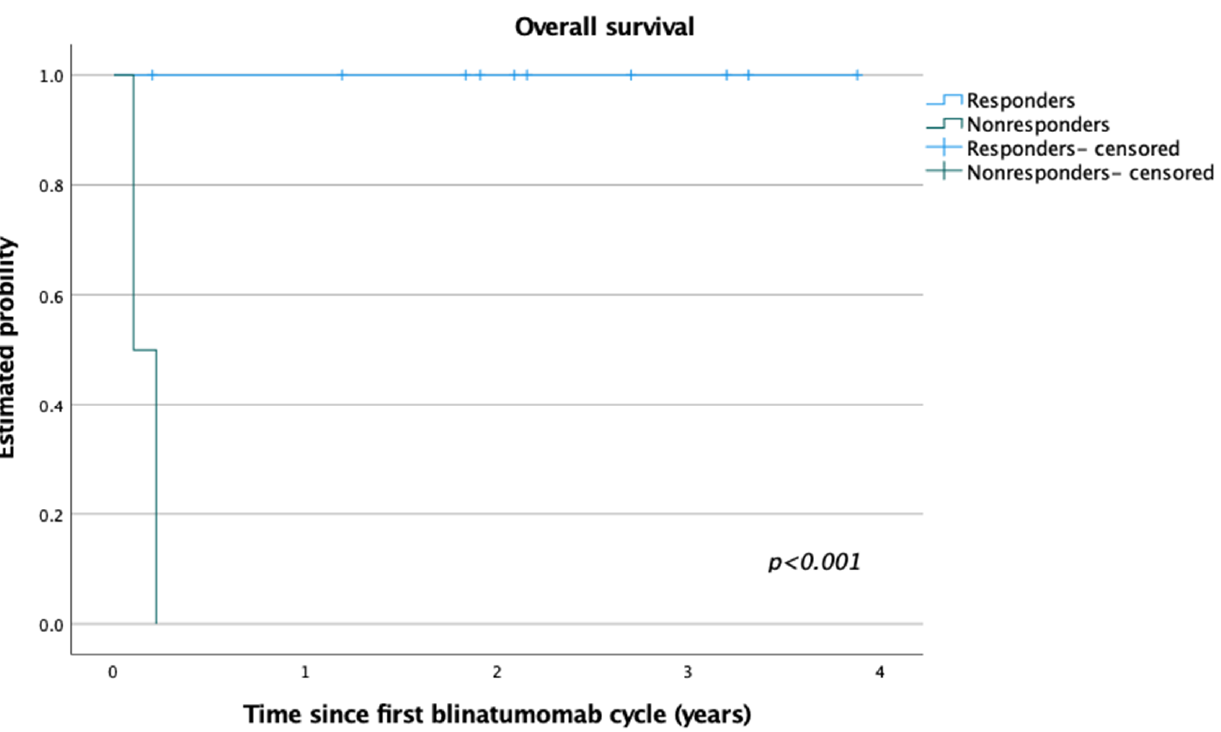
Figure 1. Overall survival (OS) for patients who responded to blinatumomab therapy (responders) vs. those who did not respond to the first cycle (nonresponders). Three-year OS for the study patients = 85% (Mantel–Cox, p < 0.001; median follow-up, 25.4 months).